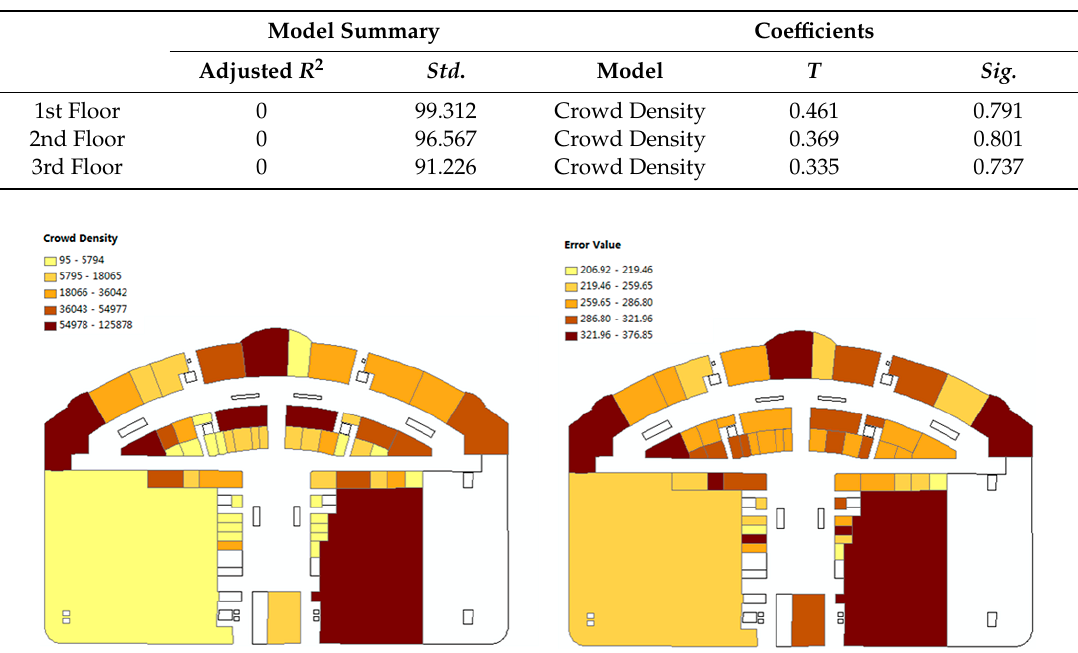
Table 3. Correlation analysis between the crowd density and error outside the store.